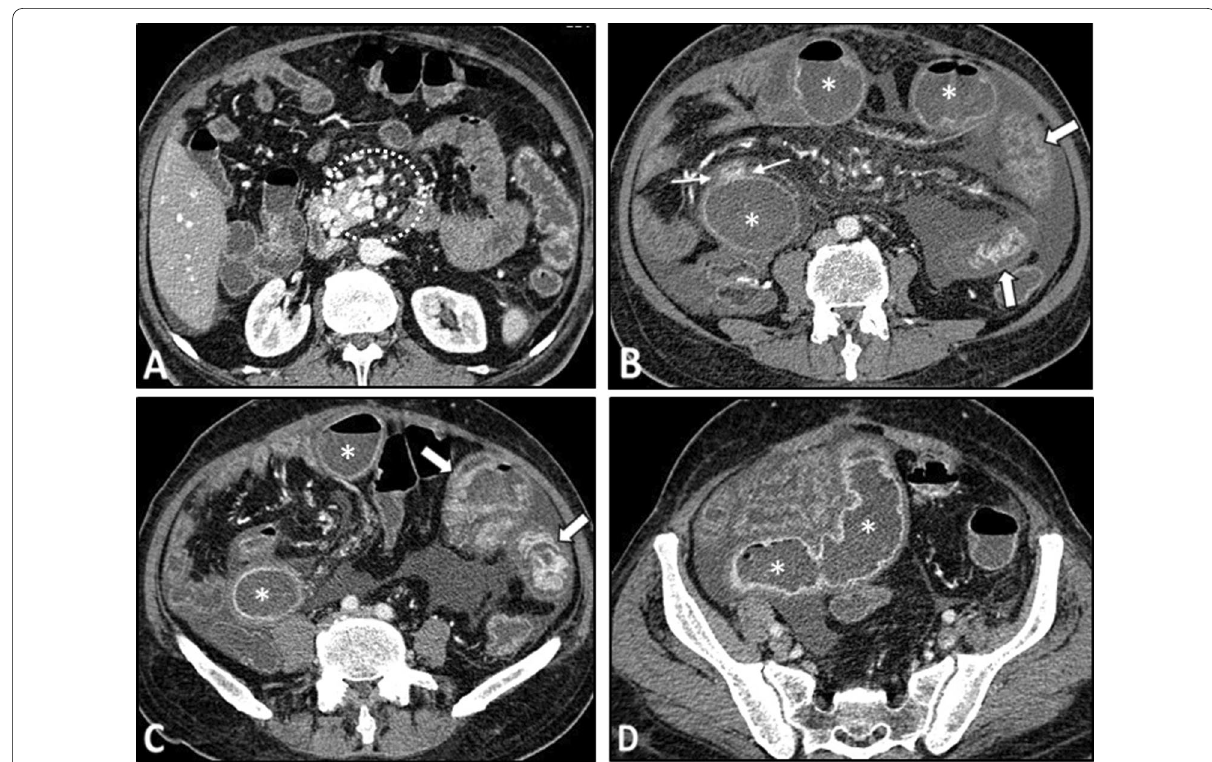
Fig. 17 Bowel stricture with secondary bacterial overgrowth in a 44-year-old male with a history of primary antiphospholipid antibody syndrome. He presented with abdominal pain, fever, nausea, vomiting, and diarrhea without a history of previous surgery. CTE was obtained. Axial CT ( A ) shows evidence of chronic SMV thrombosis associated with multiple collateral veins in the mesenteric root (white dotted oval). CT images ( B – D ) demonstrate diffuse mural thickening at jejunal loops with submucosal edema and mucosal hyperenhancement (thick white arrows). There is an abrupt stricture in a segment of proximal ileum (thin white arrows) leading to upstream bowel dilatation (white asterisks) suggestive of partial obstruction with development of ascites. The clinical and imaging findings were suspicious for focal stricture secondary to an old vascular insult with secondary bacterial overgrowth in dilated jejunal and proximal ileal loops. The patient underwent antibiotic therapy, bowel rest, and conservative management resulting in improvement of signs/symptoms. He was discharged with an uneventful